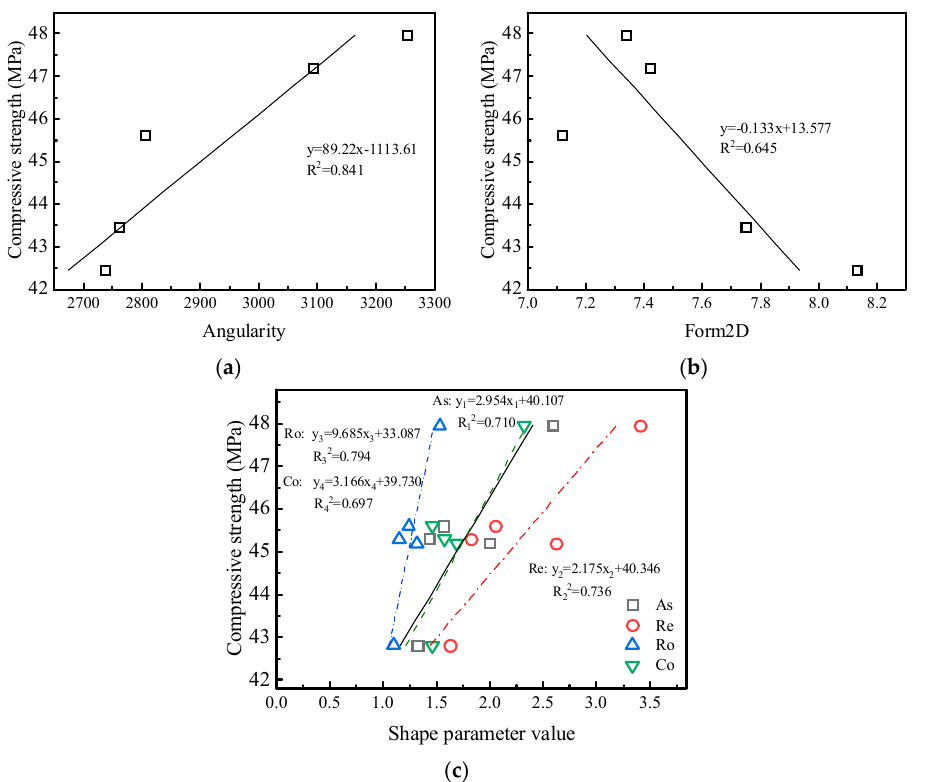
Figure 20. Correlation between particle shape parameters and mechanical properties of concrete: ( a ) angularity, ( b ) form2D, ( c ) and DIP shape parameters.